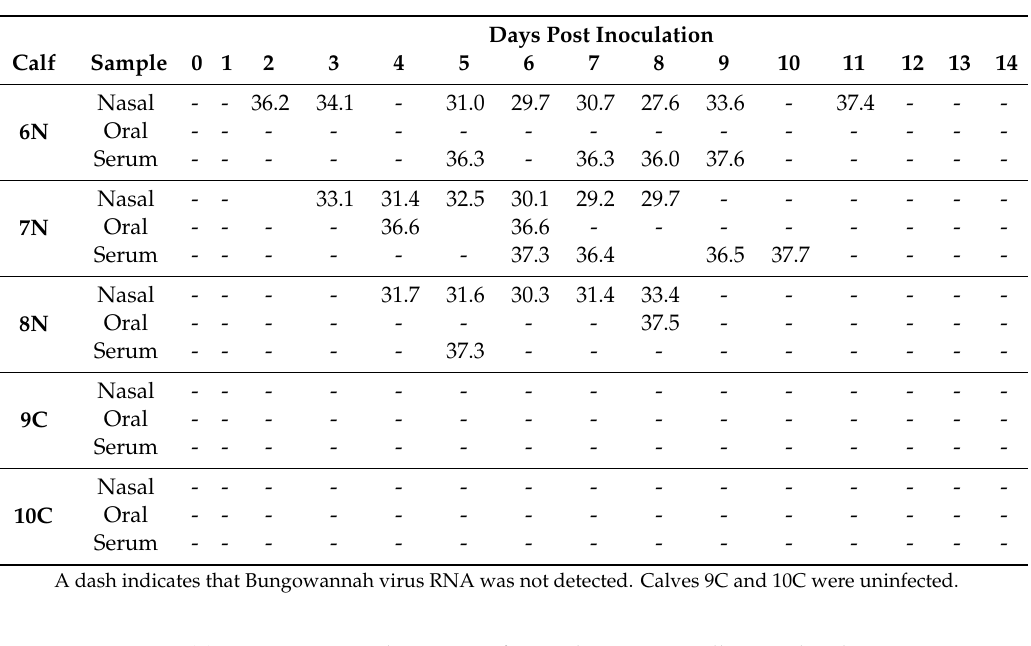
Table 4. Bungowannah VN titres from calves intranasally inoculated. Days Post